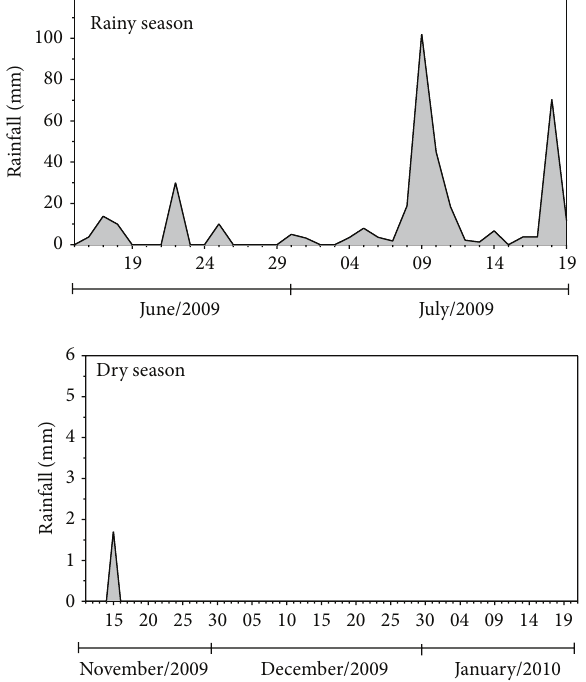
Figure 1: Rainfall (mm) in the experimental area in the rainy and dry